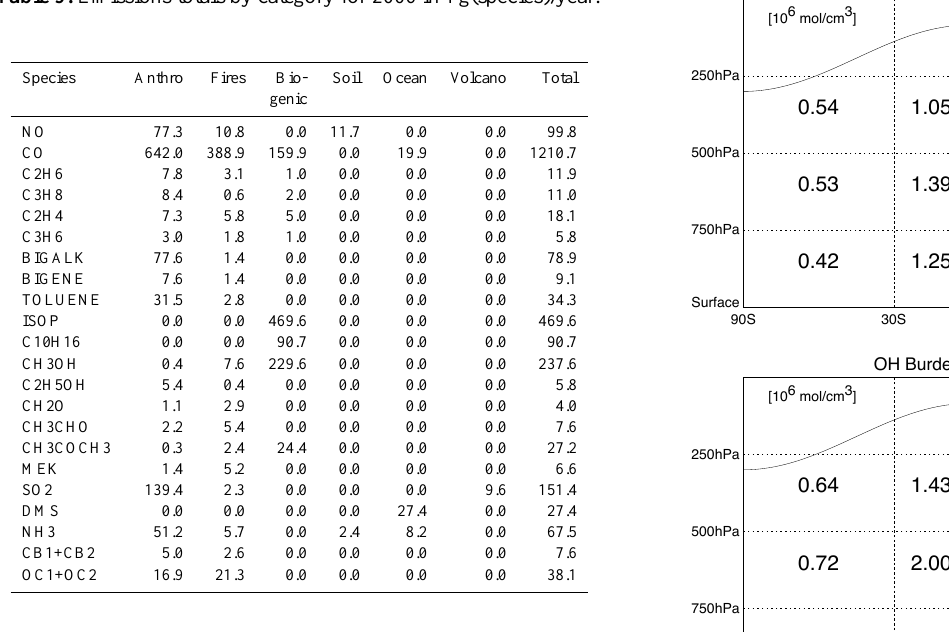
Table 9. Emissions totals by category for 2006 in Tg(species)/year.